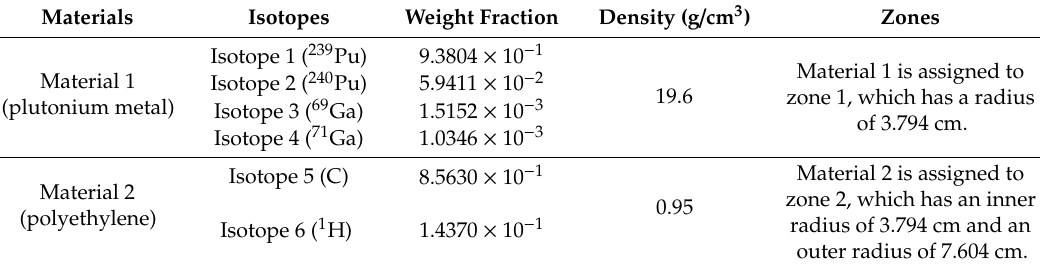
Table 1. Dimensions and material composition of the PERP